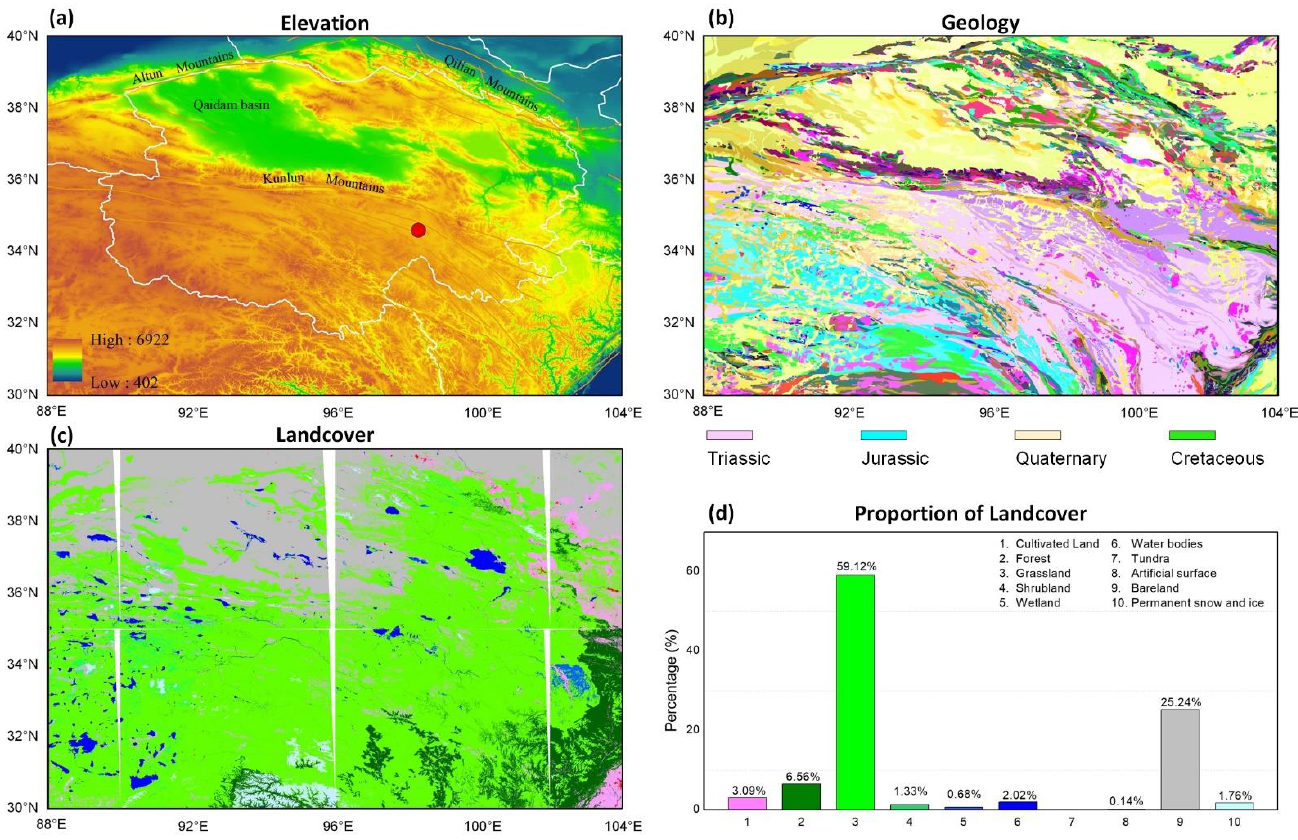
Figure 3. Distributions of elevation ( a ), geology ( b ), landcover and the proportion of each item ( c , d ) in the study area. The red circle in ( a ) represents the epicenter of the Maduo earthquake. The elevation is derived from SRTM-DEM dataset with 90m resolution, the geological map is provided by 1:1 million spatial databases of geological maps of the People's Republic of China [33], and the landcover data comes from the GlobeLand30 Dataset [34].